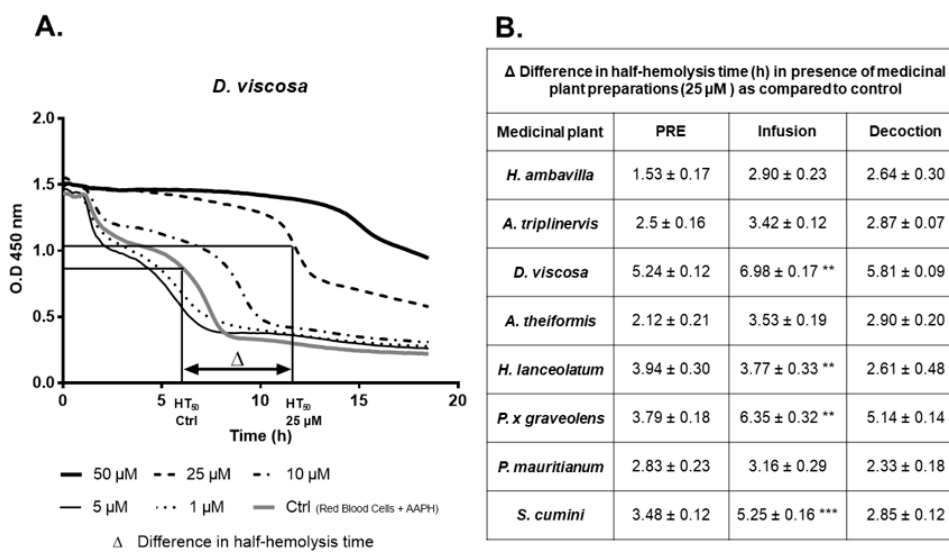
Figure 4. Effect of medicinal plant preparation on the half ‐ time hemolysis (HT50) of red blood cells. Red blood cell hemolysis was induced by AAPH. Optical density at 450 nm was measured every 3 min for 18.5 h. The decrease in optical density indicated the progression of hemolysis. ( A ) Example of hemolysis kinetics when red blood cells where co-incubated with AAPH free-radical and D viscosa infusions at different polyphenol final concentrations. ( B ) Table summarizing the delayed red blood cell half-hemolysis time (h) in the presence of medicinal plant preparations (25 µ M) depending on extraction mode. Data are means ± SEM of three independent experiments. ** p < 0.01, *** p < 0.005 as compared to decoctions.